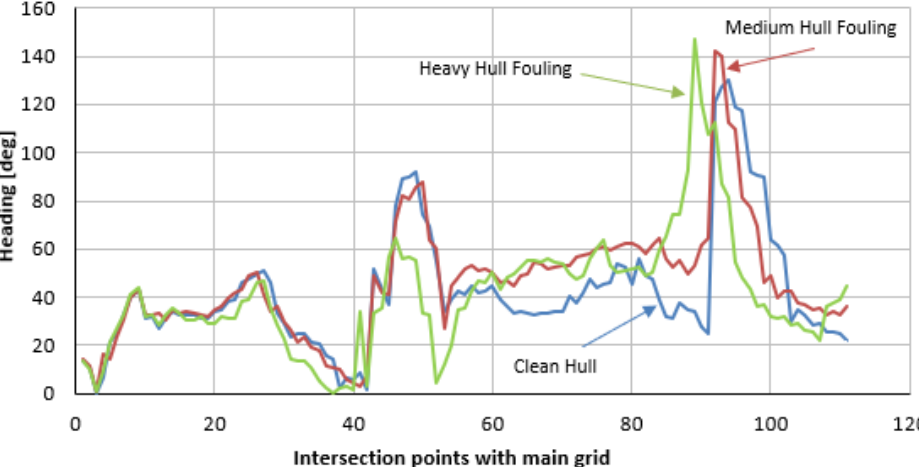
Figure 12. Relative wave heading corresponding to optimum paths for different hull fouling condi- tions.